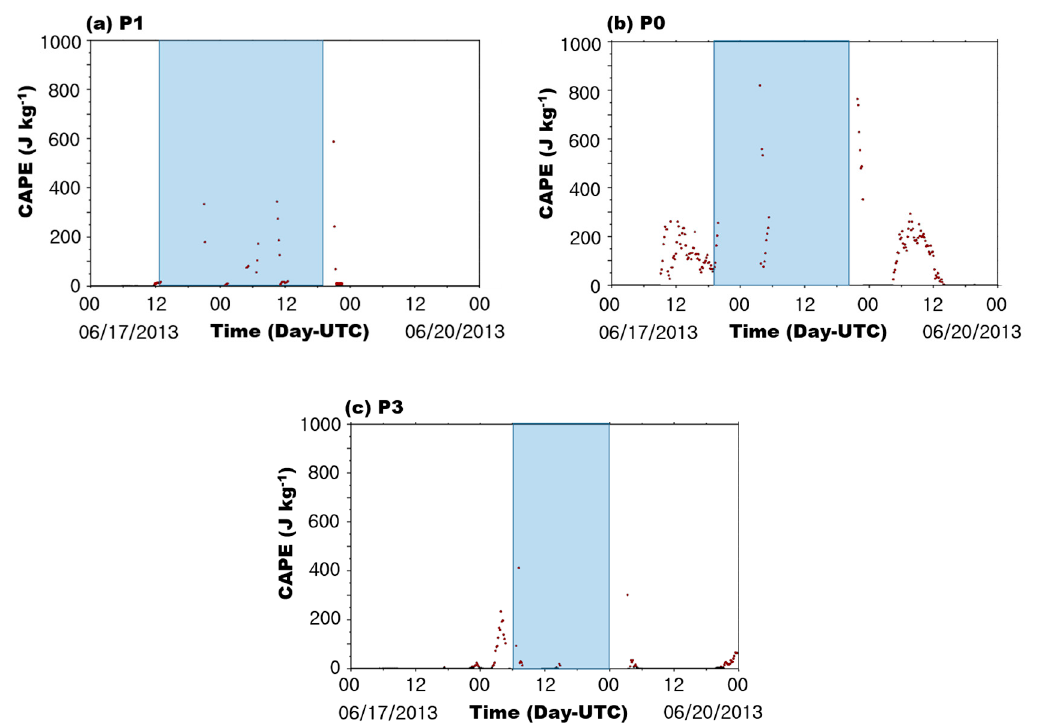
Figure 10. Same as Figure 8 but for convective available potential energy (CAPE) ( a ) at P1, ( b ) at P0, and ( c ) at P3.